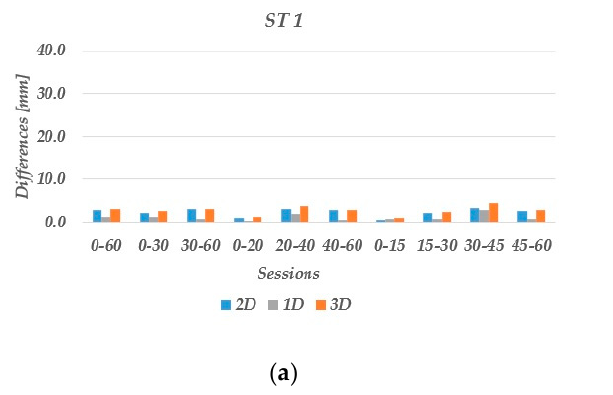
Table 1. Used parameters in the data processing.